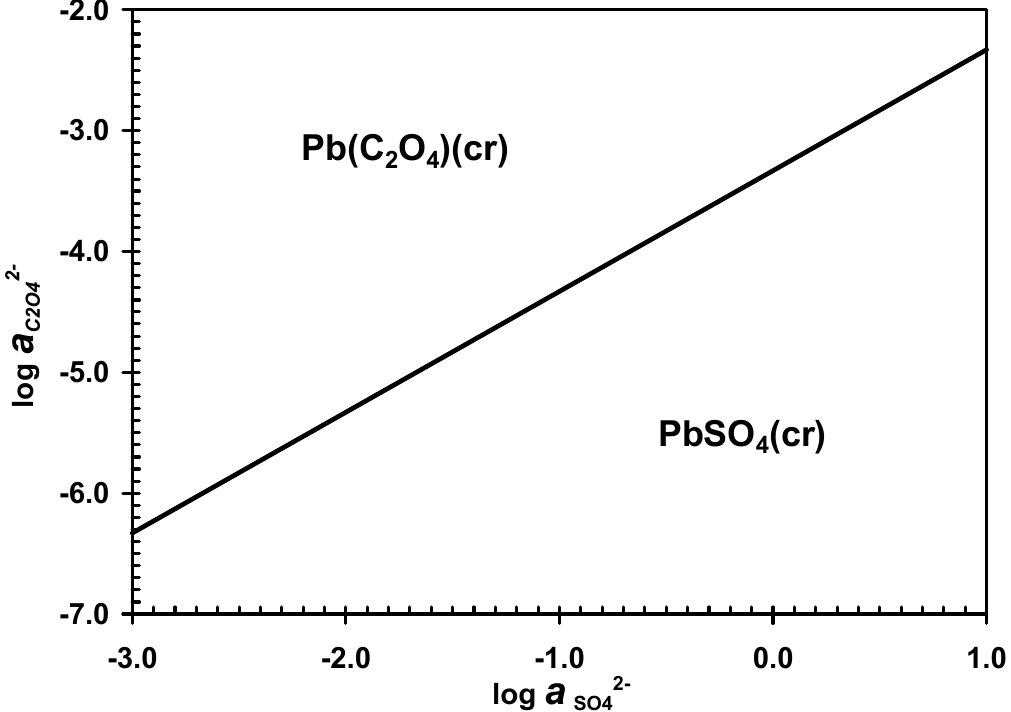
Figure 1. The stability fields of lead sulfate [PbSO 4 (cr), anglesite] and lead oxalate [PbC 2 O 4 (cr)] at 25